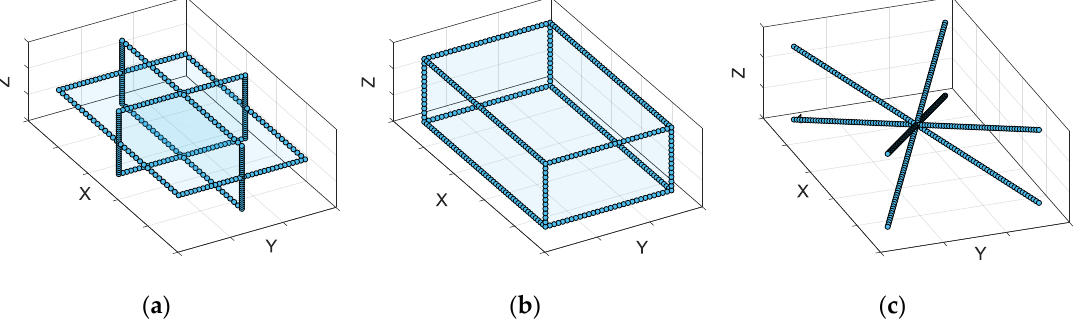
Figure 4. Measuring trajectories to be compared: ( a ) Orthogonal planes; ( b ) Hexahedron; ( c ) Main Figure 4. Measuringtrajectoriestobecompared: ( a )Orthogonalplanes; ( b )Hexahedron; ( c )Maindiagonals. diagonals.